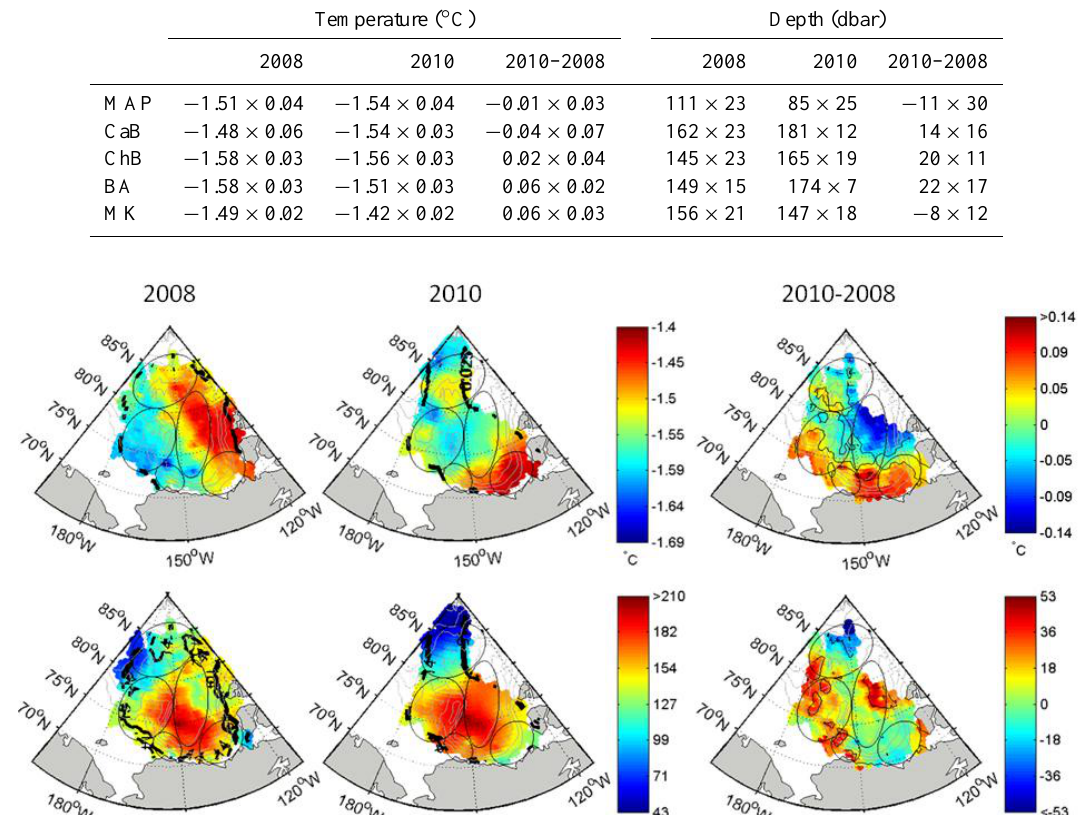
Table 4. Temporal evolution of the WPaW characteristics in the five areas between 2008 and 2010.